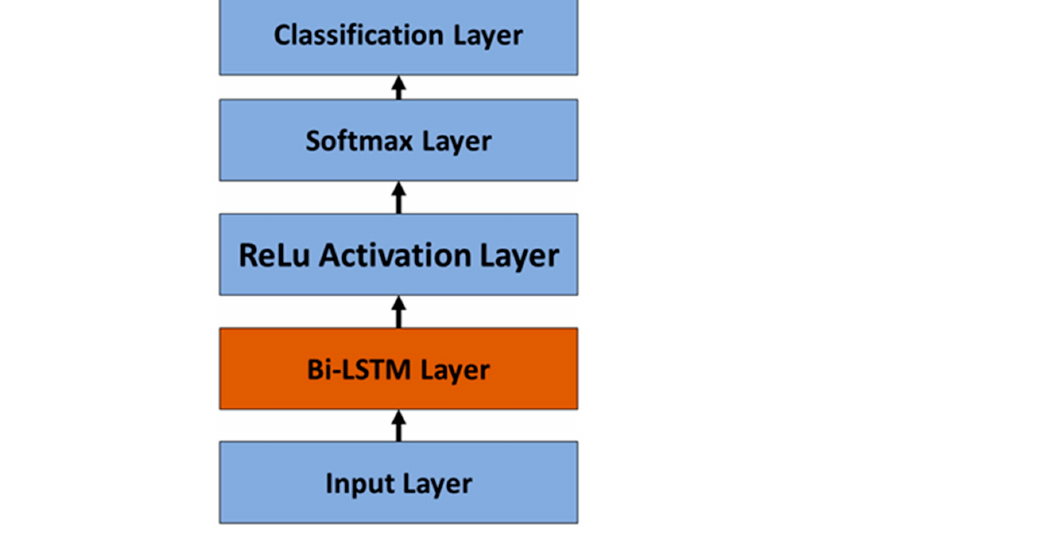
Figure 7. Proposed UA using Bi-LSTM based deep learning architecture.